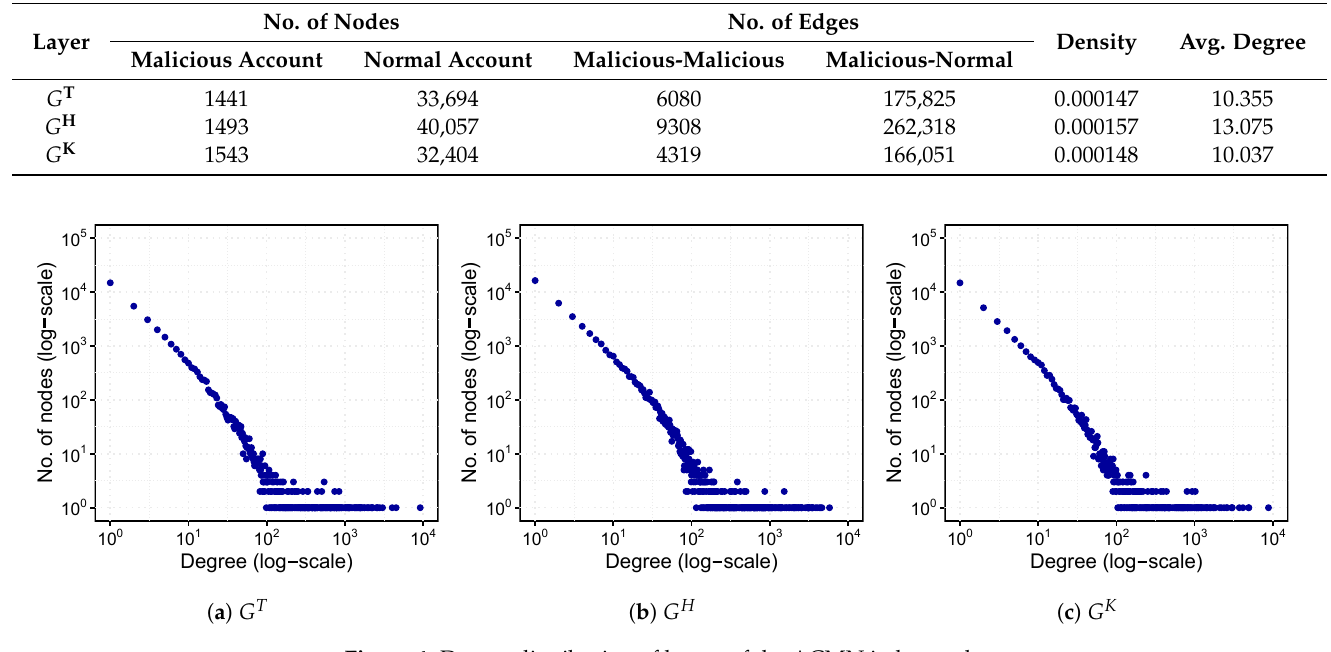
Figure 4. Degree distribution of layers of the ACMN in